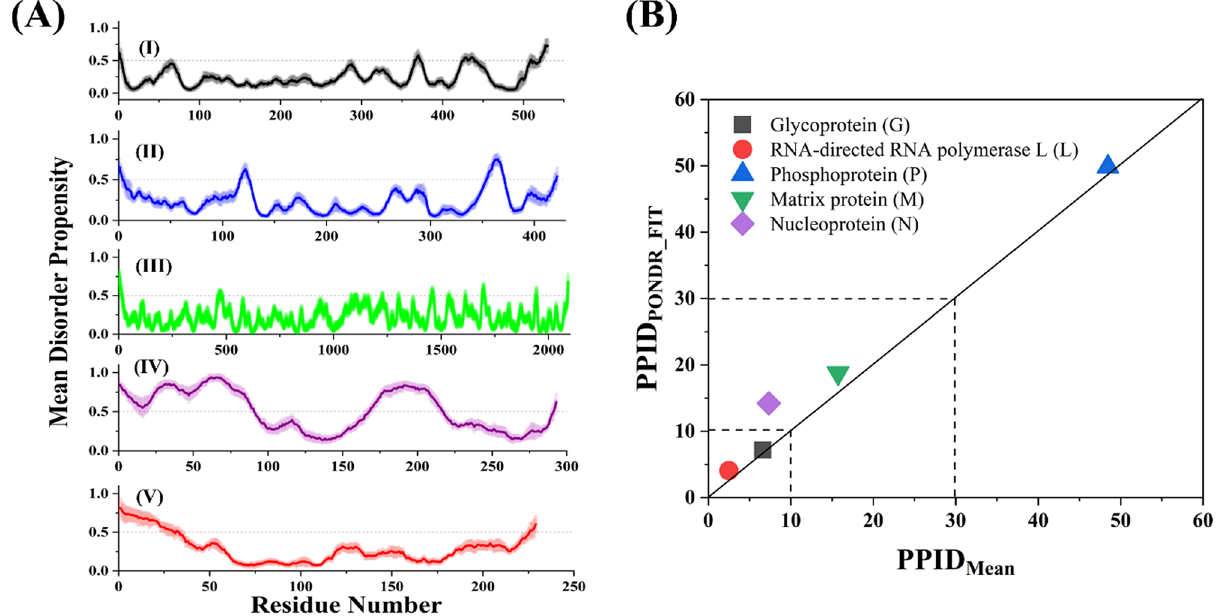
Figure 2. Evaluation of overall disorder status of five proteins of CHPV. ( A ) Mean disorder tendency with standard error (highlighted on the plot) for all five proteins of CHPV, (I) G, (II) N, (III) L, (IV) P, and (V) M. ( B ) 2D disorder plot represents the PPID PONDR-FIT vs. PPID mean dependence.